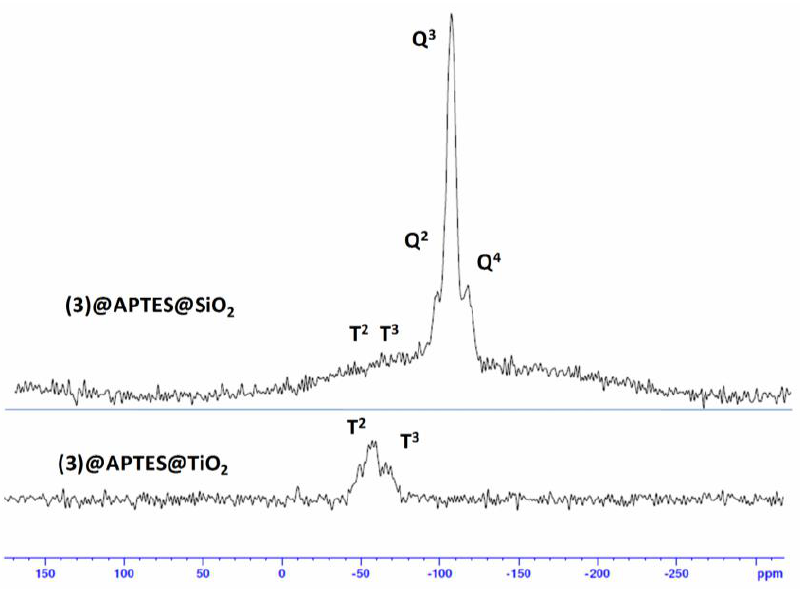
Figure 11. Solid-state 29 Si CPMAS NMR spectra of (3) @APTES@SiO 2 and (3) @APTES@TiO 2.